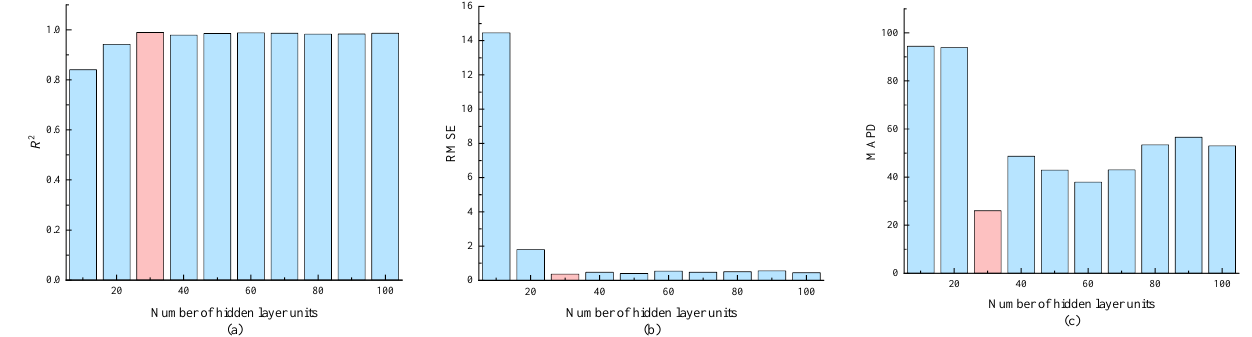
Figure 3. Statistical indicators with the whole number of hidden-layer units in RBFNN between 0 and 100: ( a ) R 2 ; ( b ) RMSE ; ( c ) MAPD . The red part represents the best performing hidden layer unit, and the blue part represents other units within the range.